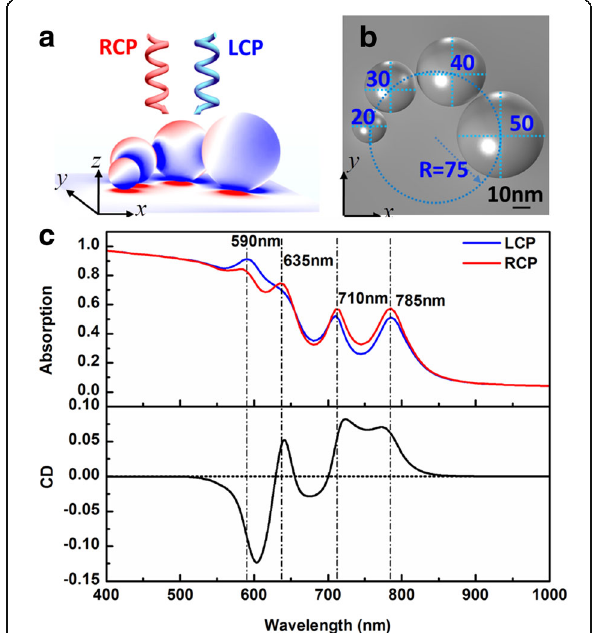
Fig. 1 Excitation model of a chiral particle chain-film system and the optical properties. a Oblique view: The chiral particle chain is consisted of closely spaced Ag nanospheres with different radius of 20 nm (smallest), 30, 40, and 50 nm (largest) and is placed on a 100-nm- thick gold film with 1 nm gap. The circularly polarized light with left-hand circular polarization (LCP) or right-hand circular polarization (RCP) illuminates from the chiral particle chain side normal to the Au film. The surrounding medium of the Ag nanospheres is air. b Top view: The center of every particle of the chiral particle chain is on a same circle with radius R in the x - y plane (as shown with blue dotted line). The radius of every particle is shown with Arabic numbers in the figure and the unit is nanometer. The smallest spaces of each two adjacent particles are 2 nm. c Optical properties of chiral particle chain- film system. The blue and red solid lines represent the absorption spectra for RCP and LCP light, respectively (labeled as LCP and RCP). Lower panel: the corresponding circular dichroism (CD) spectrum is shown with black solid line. The vertical dashed lines from left to right correspond to the peaks at 590, 635, 710, and 785 nm,